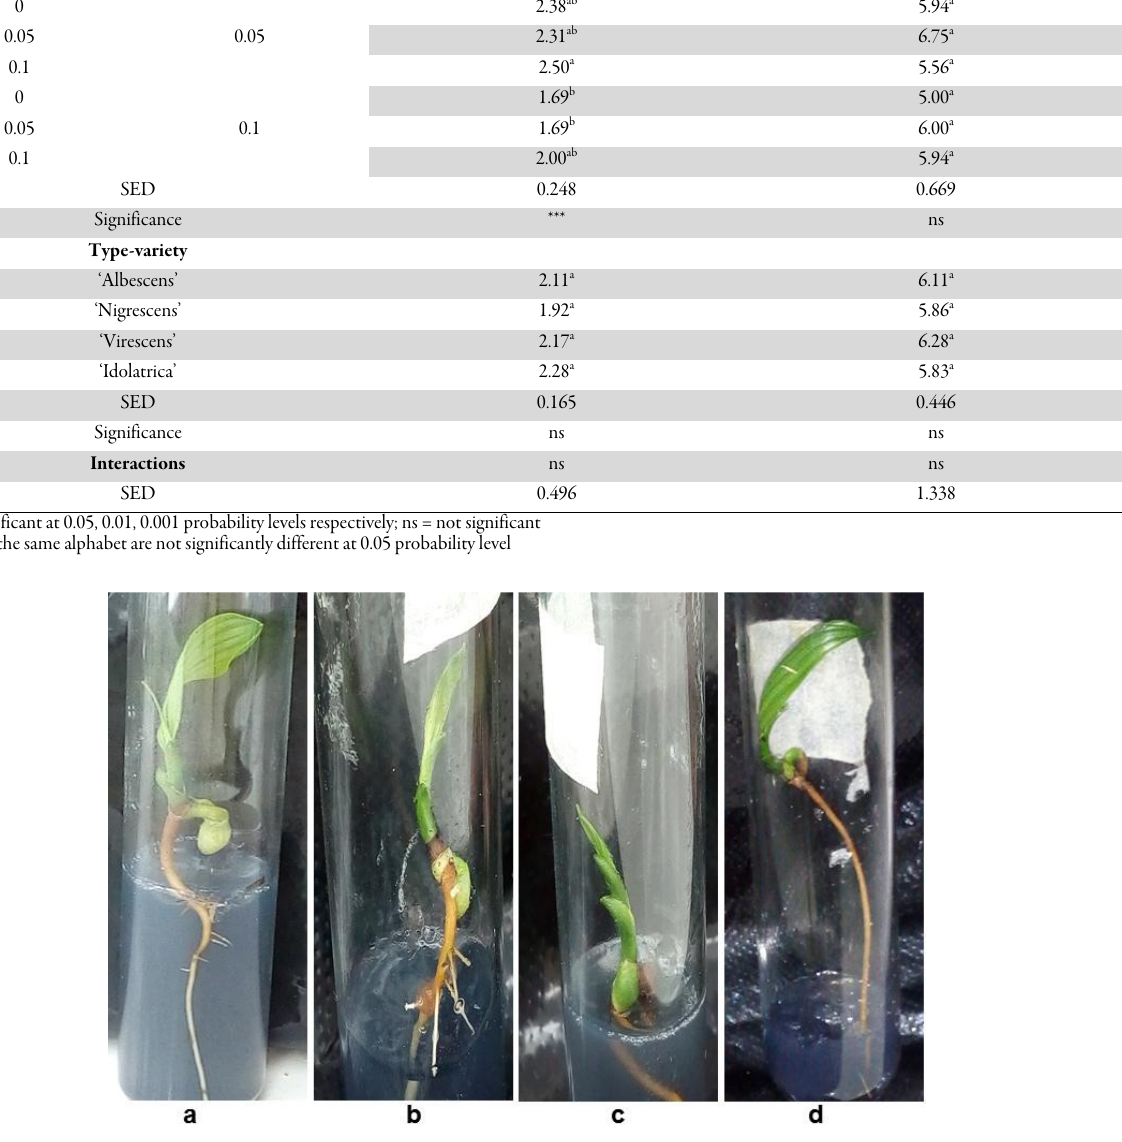
Fig. 3. Plantlets generated 84 days after culture initiation of type-variety of oil palm; (a) ‘Idolatrica’; (b) ‘Albescens’; (c) ‘Nigrescens’; (d)